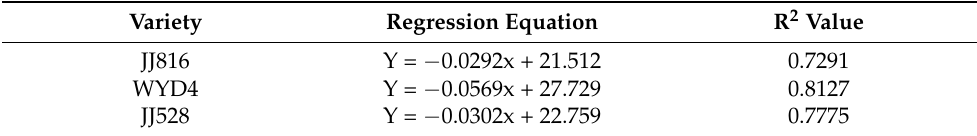
Table 2. Regression equation and correlation coefficient of each rice variety in 2019. Variety